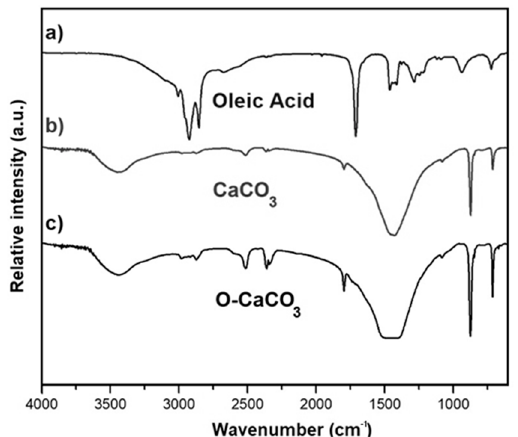
Figure 3. Fourier transform infrared (FTIR) spectra of ( a ) Oleic acid, ( b ) CaCO 3 nanoparticles, and ( c ) nanoparticles modified with oleic acid (O-CaCO 3 ).